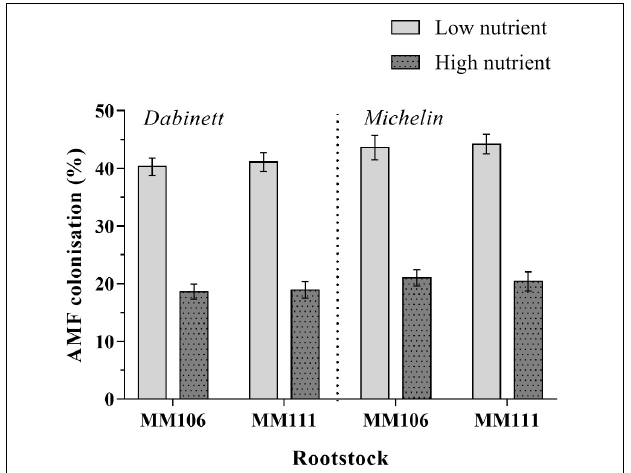
FIGURE 1 | Root colonisation of apple trees ( Malus pumila ) inoculated with two species of arbuscular mycorrhizal fungi (AMF). Mean AMF colonisation after 3 years of growth under high and low nutrient treatments and for both Dabinett and Michelin scions is presented. Error bars represent ± SE per treatment ( n = 20). AMF colonisation was significantly affected by both scion type ( P < 0.05) and nutrient treatment ( P < 0.001) but not rootstock type.